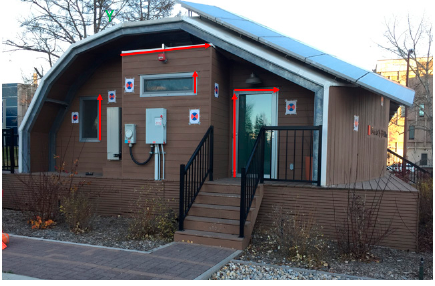
Figure 9. Straight Linear Feature Constraints.